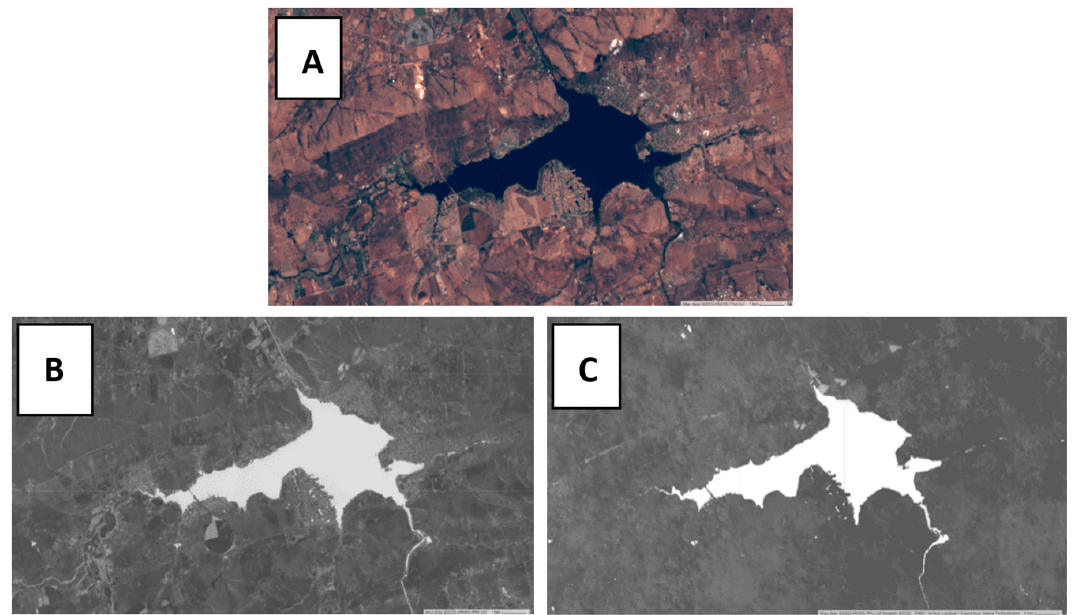
Figure 4. A portion of an RGB Landsat-8 image ( A ), corresponding derived modified normalized difference water index (MNDWI) image ( B ) and 95th percentile image derived from a long term (2013–2019) MNDWI image collection ( C ) over Hartbeespoort Dam, South Africa. The benefit of using a 95th percentile image is shown by its ability to decrease the MNDWI pixel values over non-water areas (e.g., agriculture) while increasing the MNDWI values of water pixels. This helps enhance the contrast between water and non-water pixels.